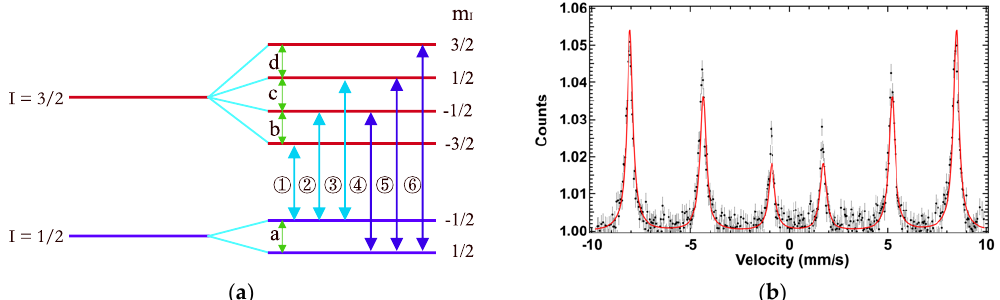
Figure 1. ( a ) HFS of 57 Fe nucleus (a, b, c, d are called ‘prime beat components’, they represent the energy gaps between energy levels of HFS; Line ① ~ ⑥ represent the six allowed transitions; m I represents the nucleus magnetic quantum number after Zeeman-splitting); ( b ) the conventional MS of Fe 2 O 3 (the black dots represent the experimental data of conventional MS and the red multi-peak curves are the fitting result of experimental data) [24].